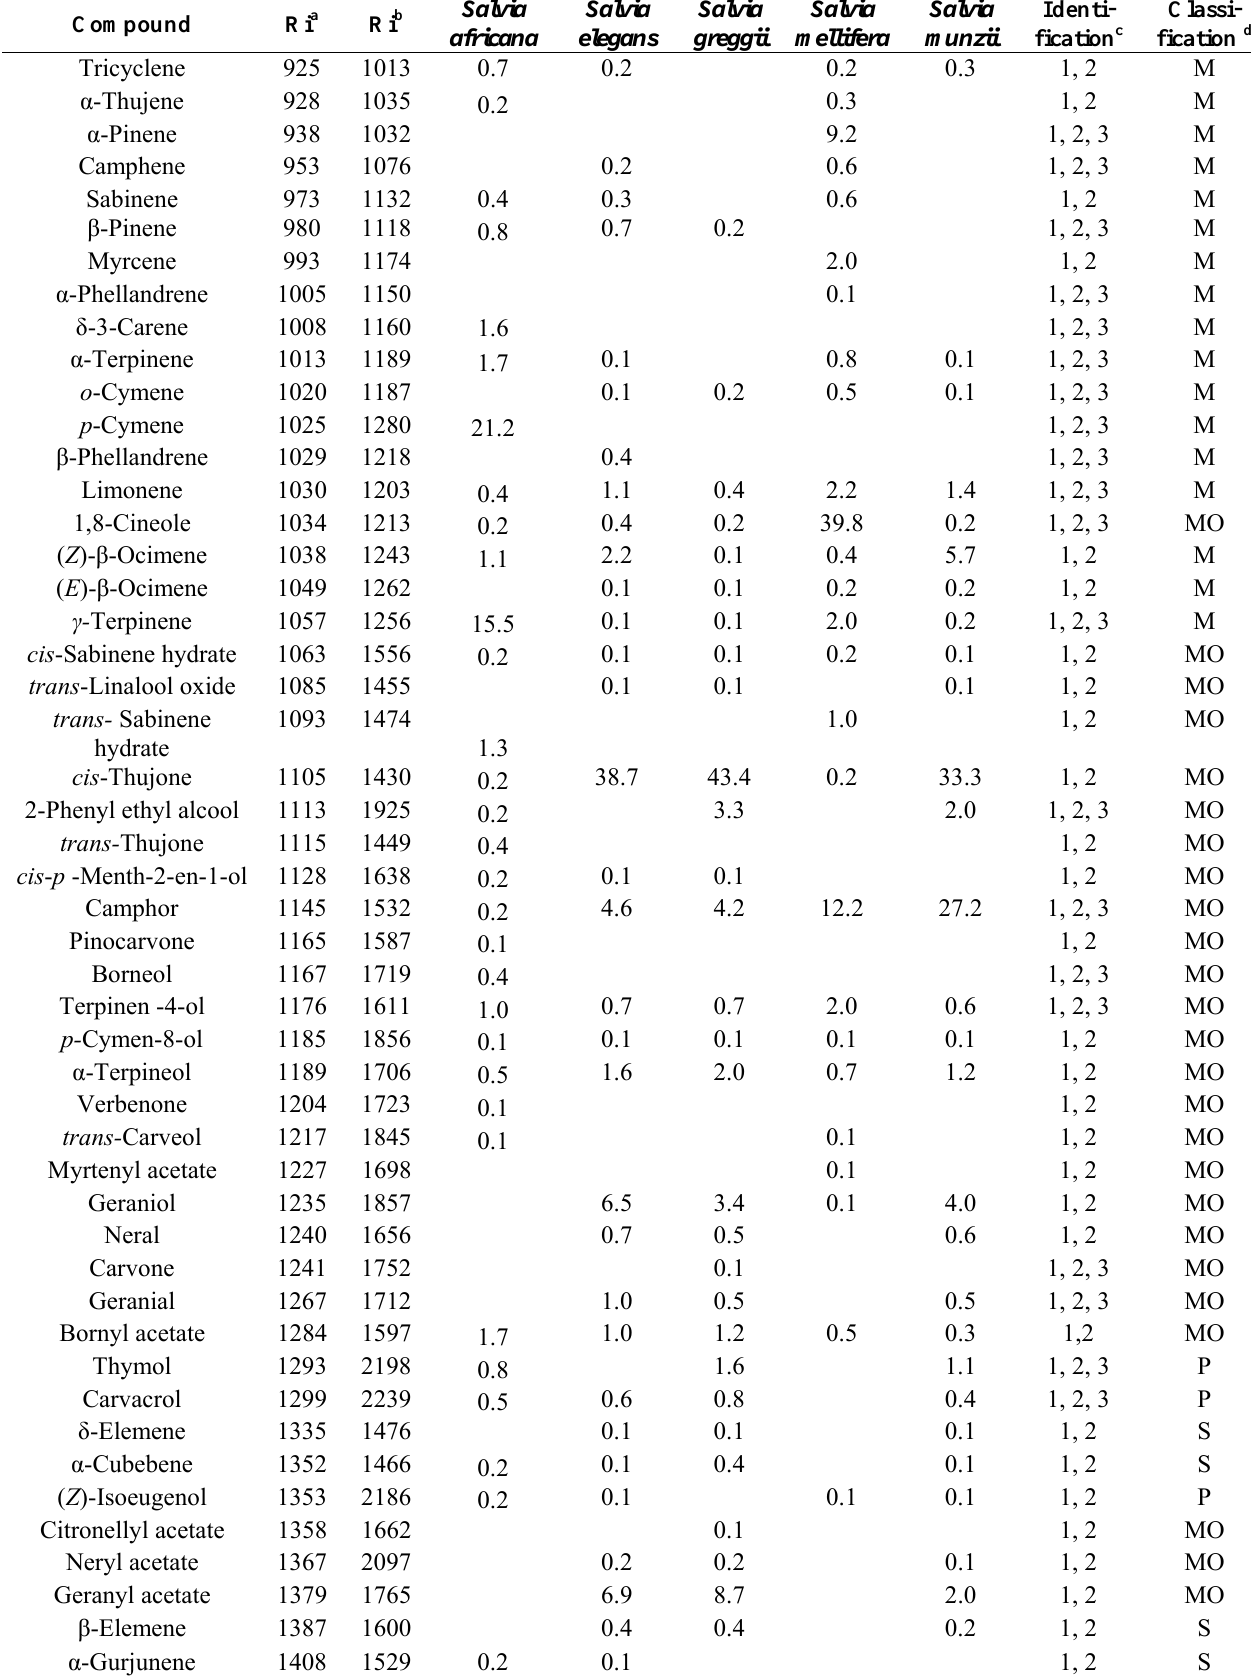
Table 1. Essential oil composition of Salvia africana , Salvia elegans , Salvia greggii , Salvia mellifera and Salvia